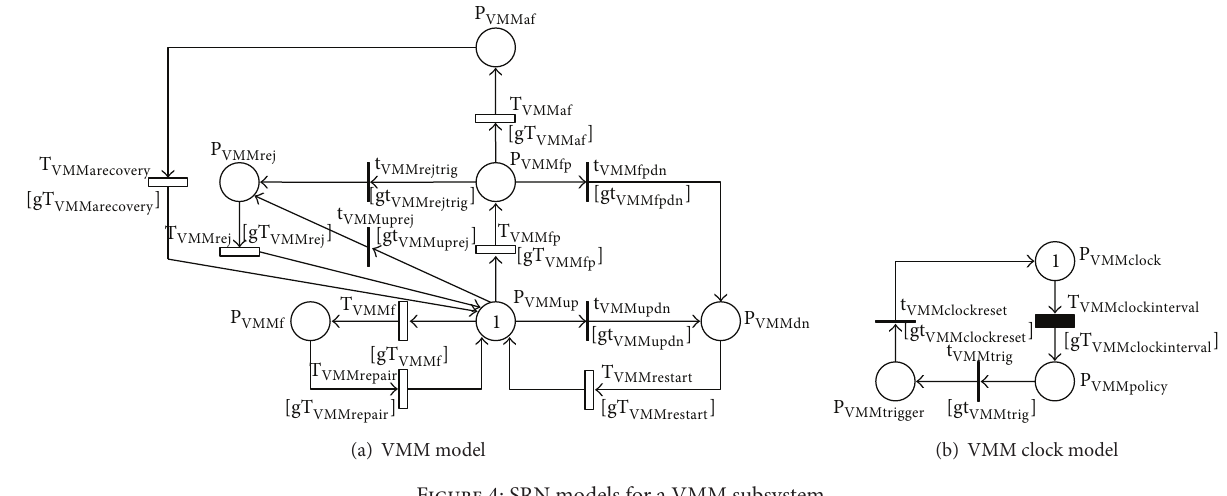
Figure 4: SRN models for a VMM subsystem. Table 1: Guard functions for the VMM submodel and VMM clock